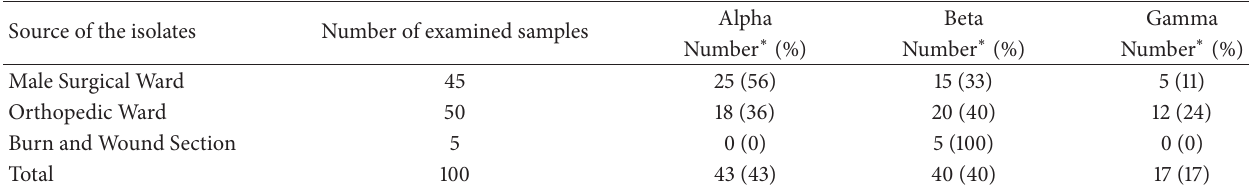
Table 4: Hemolytic activity of clinical isolates of Staphylococcus aureus .